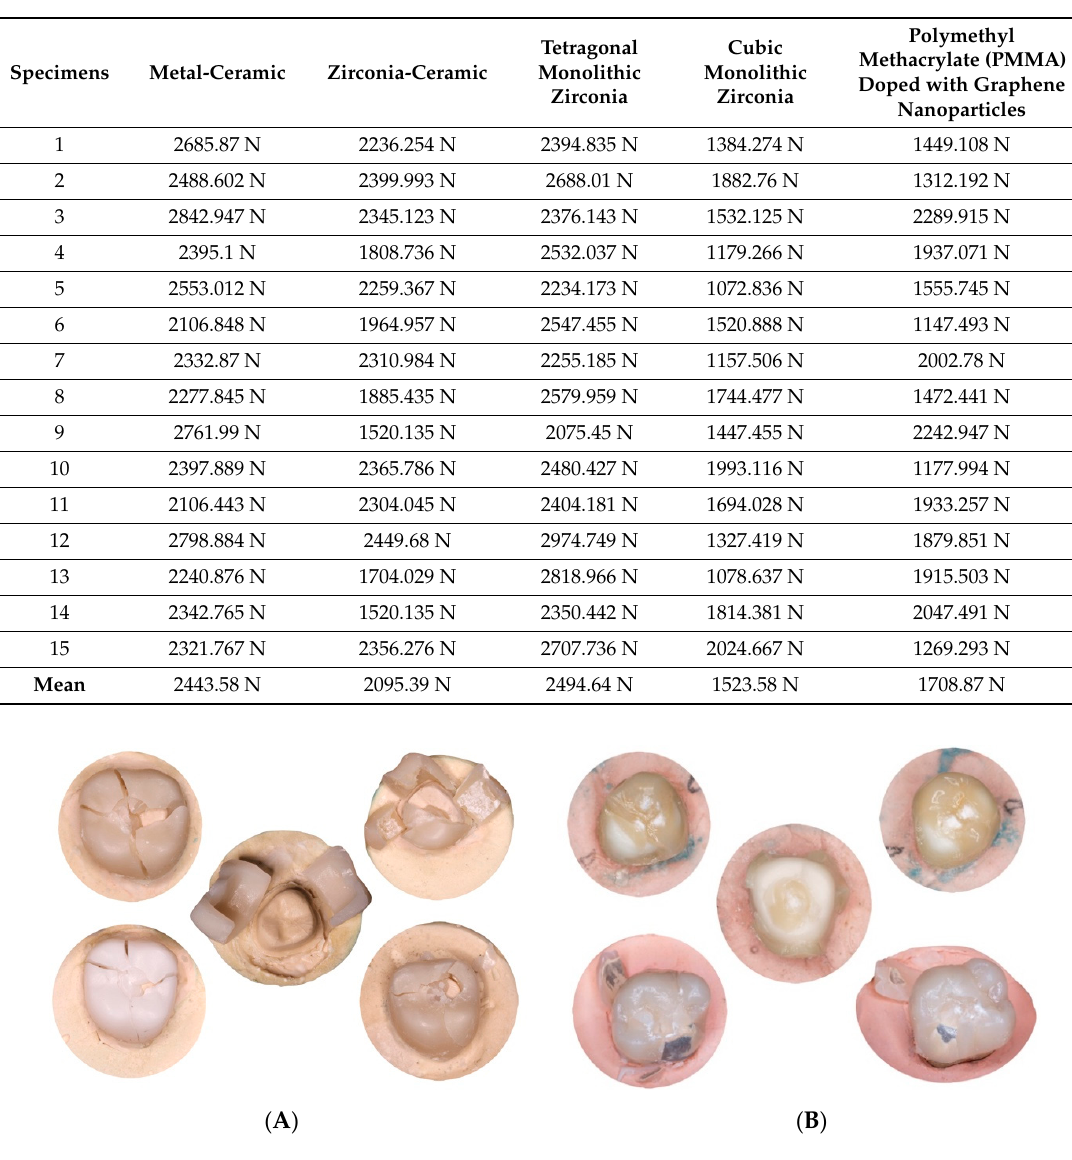
Table 1. Resistance results of each group after the dynamic and static test.